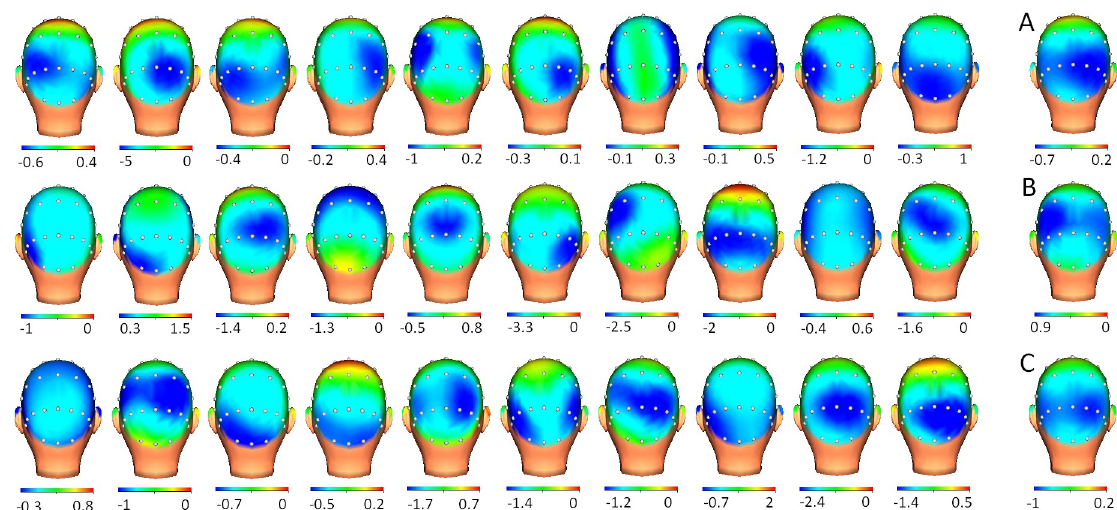
Fig 2. Grand average and individual 3D head maps of ERD (event-related desynchronization) for healthy, low- and moderate-EDSS groups. 3D head maps are displayed for each of the 10 participants of each group (upper line: healthy group; midline: Low EDSS group; bottom line: Moderate EDSS group) and the grand average for each group (A): healthy; (B): Low EDSS and (C) Moderate. Note that GA topographies were similar between groups.